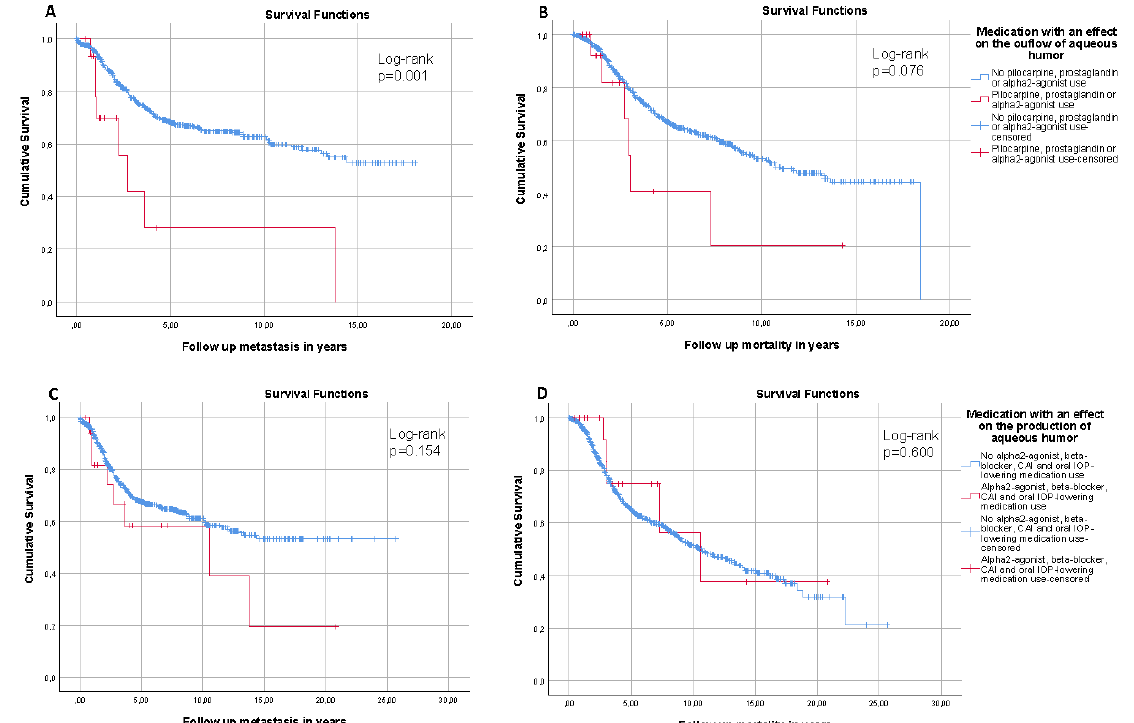
Figure 2. Kaplan–Meier cumulative incidence curves of metastasis ( left ) and mortality ( right ) in uveal melanoma patients for IOP-lowering medications that increase aqueous humor outflow ( A , B ), and for IOP-lowering medications that reduce the production of aqueous humor ( C , D ).